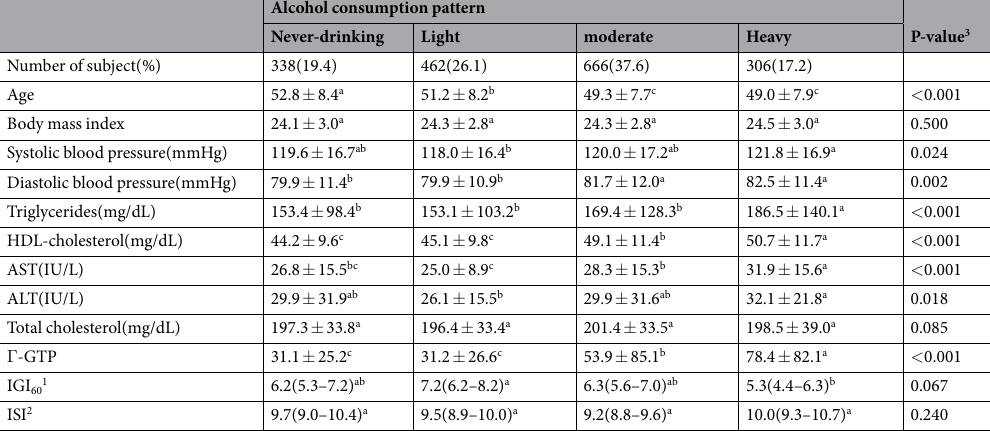
Table 1. Baseline characteristics of participants (alcohol consumption pattern categorization). All data except β -cell function and insulin sensitivity are represented as mean ± standard deviation (SD). 1 Insulin secretion refers to the insulinogenic index (IGI 60 ) and is shown as the geometric mean (95% confidence interval, CI). 2 Insulin sensitivity refers to the Matsuda index (ISI) and is shown as the geometric mean (95% confidence interval, CI). The participants were categorized into four groups based on follow-up measurement (consumption pattern). 3 p-values were determined using one-way anova and post-hoc (Duncan) for continuous variables in according to alcohol consumption pattern at baseline and over 10-years. a,b,c,d Different letters indicate significant difference of means among four groups by Duncan test.